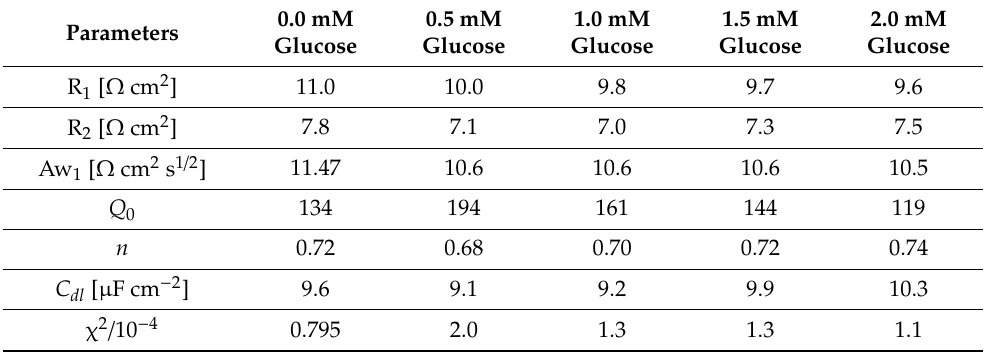
Figure 6. Randles equivalent circuit. R 1 is solution resistance, R 2 —charge transfer resistance, and Aw 1 —Warburg semi-infinite linear di ff usion element. Table 2. Equivalent circuit parameters obtained from fitting procedure applied to EIS spectra recorded in cPBS (see Figure